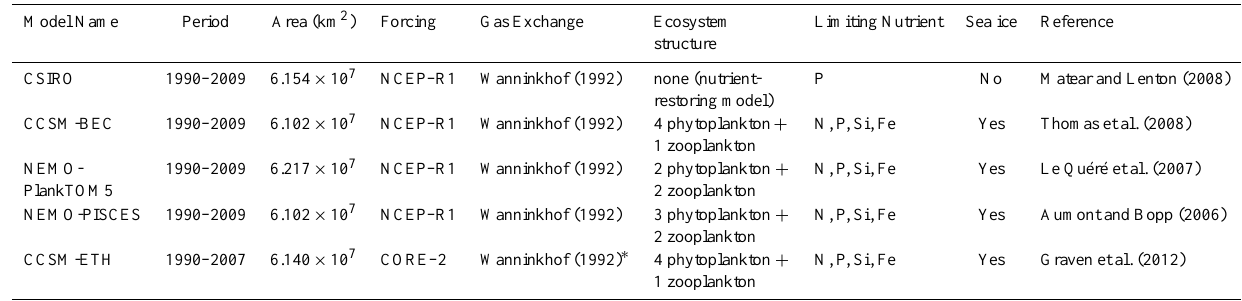
Table 1. Ocean biogeochemical models used this the study, their respective surface areas between 44 ◦ S and 75 ◦ S, the periods over which the data was evaluated, and the reference to each